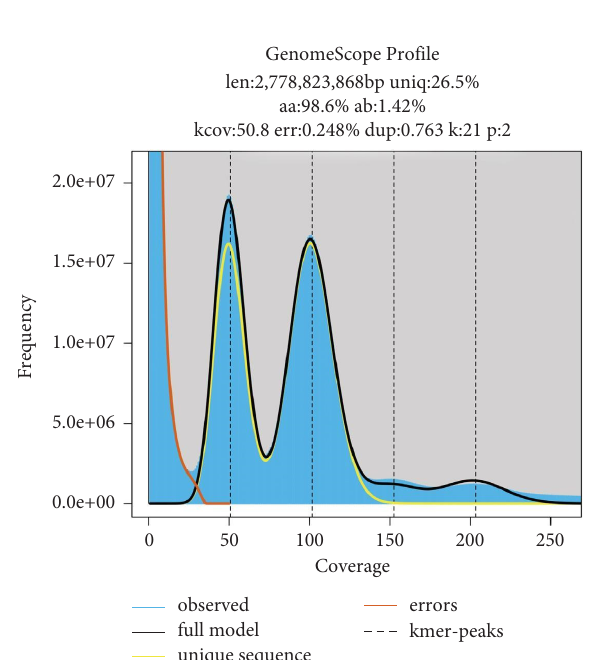
Figure 1: 21-mers distribution of the CNC genome. Blue bars represent the observed K-mer distribution; the black line represents the modeled distribution without the error K-mers (red line), up to the maximum K-mer coverage specifed in the model (yellow line). Len, estimated total genome length; Uniq, unique portion of the genome (not repetitive); het, heterozygosity rate; Kcov, mean K- mer coverage for heterozygous bases; Err, error rate; and Dup, duplication